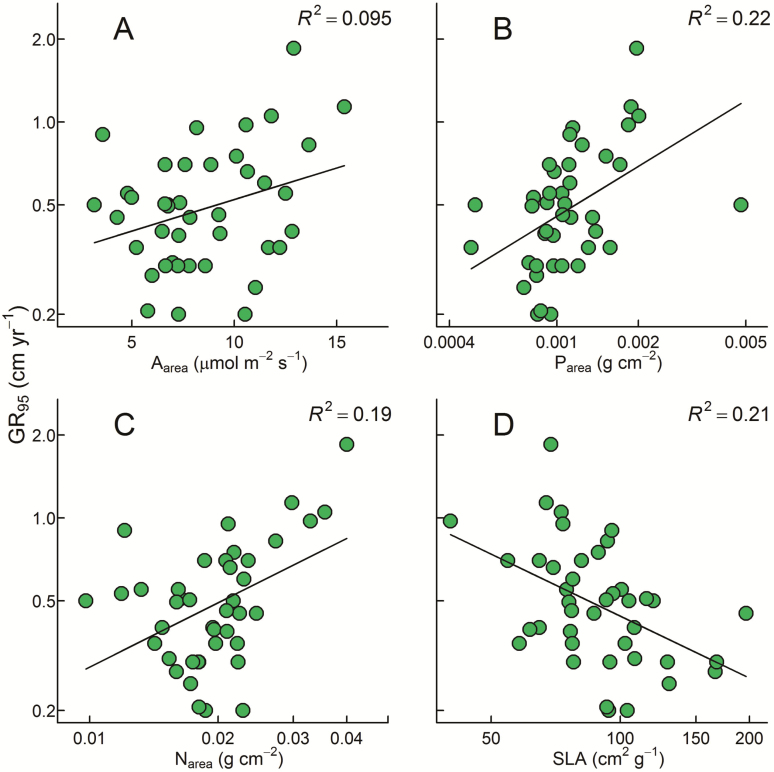
Linear regression relationships between GR95 and (A) Aarea, (B) Parea, (C) Narea and (D) SLA. All variables except for Aarea were log transformed. All relationships were statistically significant, P ≤ 0.05 [see Supporting Information—Table S5]. Relationships are for 41 tropical rainforest species (species details provided in Supporting Information).